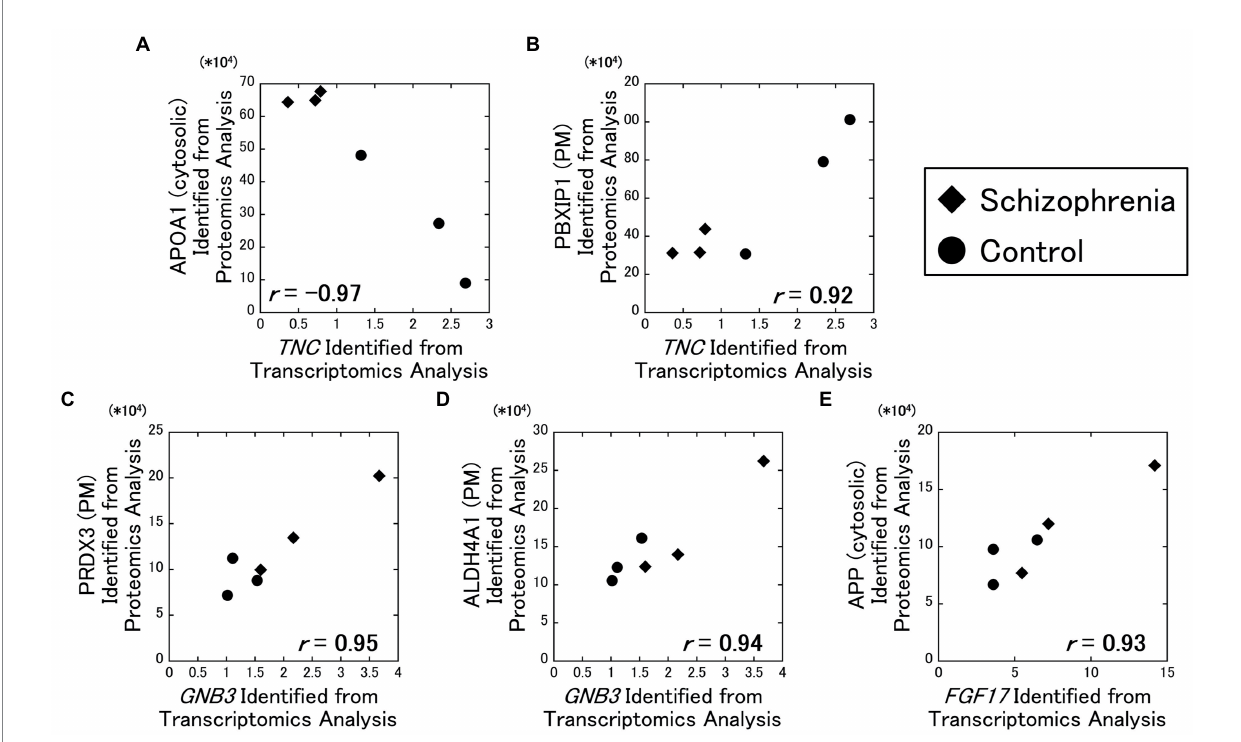
FIGURE 2 Relationships between the transcriptomics and the proteomics factors. The amounts of the identified proteins were plotted against RPKM of the DEGs. All data including other DEGs and proteins are available on Supplementary Figure 2. Diamonds: samples from schizophrenia patients. Circles: samples from control subjects.